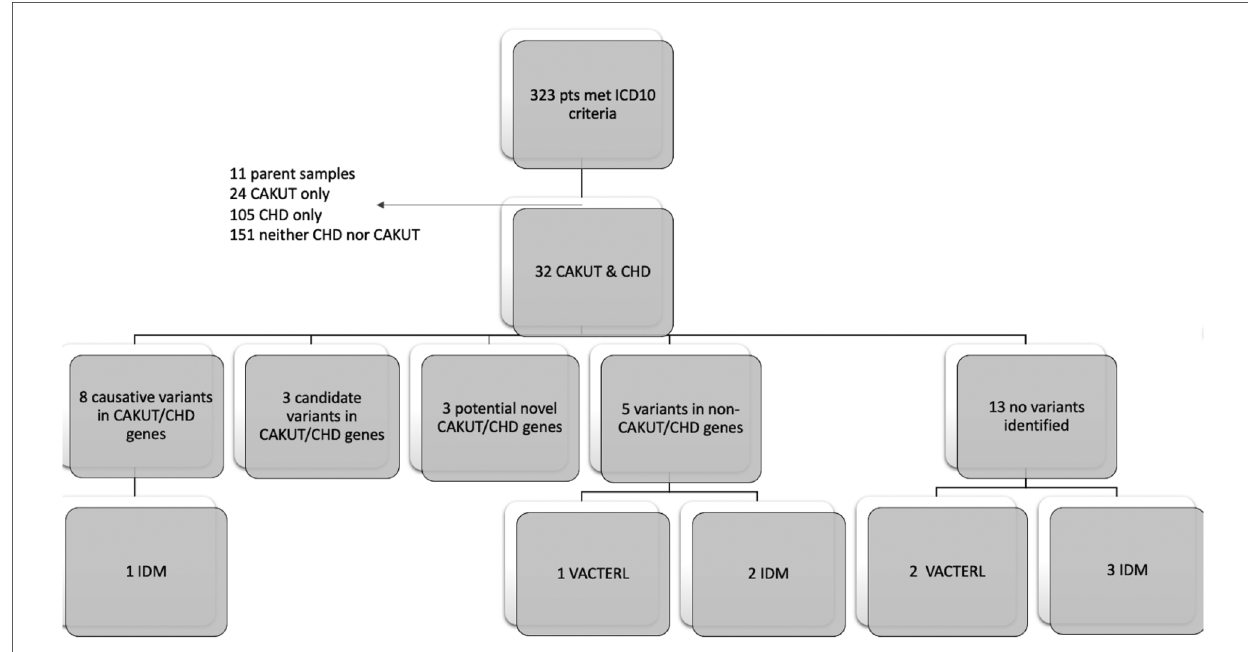
FIGURE 1 Flow diagram of patient inclusion and results: Infant of diabetic mother (IDM), Congenital heart defect (CHD), Congenital anomaly of kidney and urinary tract system